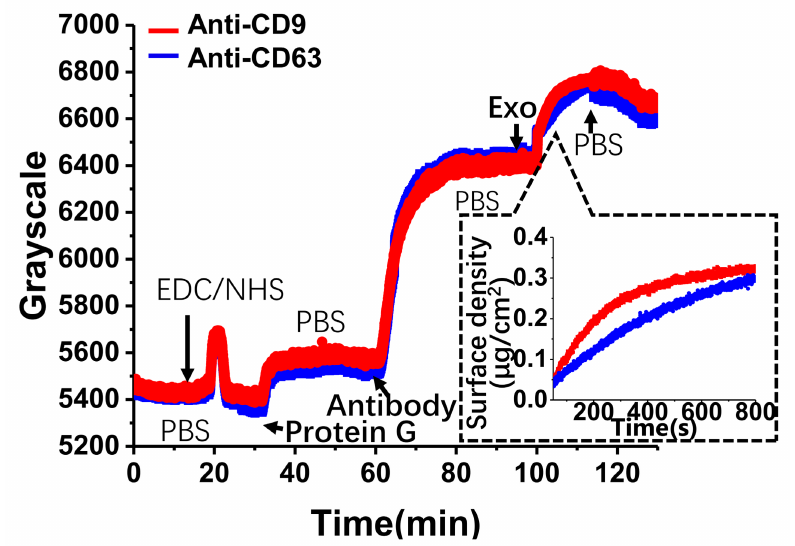
Figure 4. The real-time curve for the whole biological process on the sensing surface. The inset in the figure clearly illustrates the specific binding process between two types of antibodies (anti-CD9 and anti-CD63) and